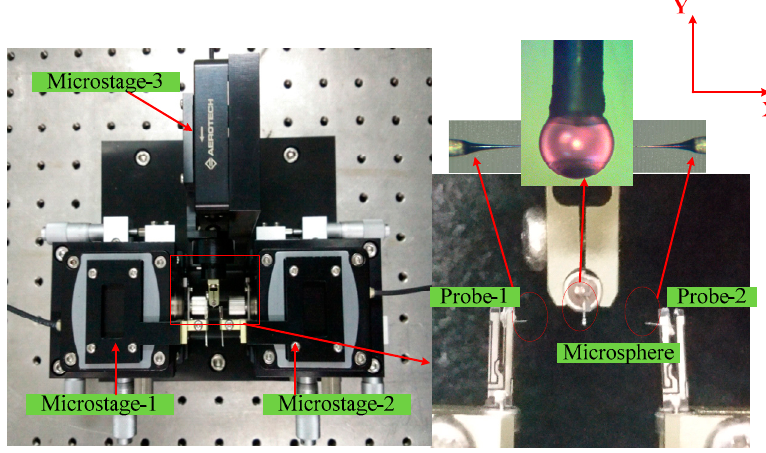
Figure 8. Photography of the measurement system.